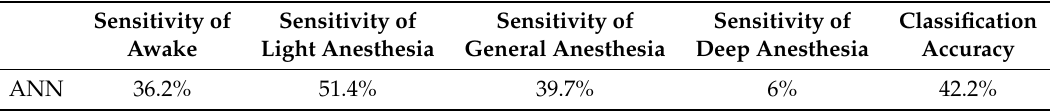
Figure A1. ( A ) The waveforms of BIS index and ANN output. The blue line is BIS index which is the target. The red line is ANN output which is the predicted value. ( B ) The scatter plot of BIS index and ANN output. ( C ) The Bland–Altman plot of BIS index and ANN output. Table A1. The results of ANN with preprocessed EEG as